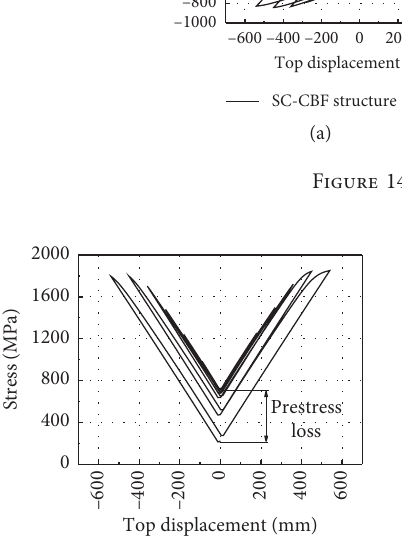
Figure 15: Curve of prestressed tendons stress versus top displacement.